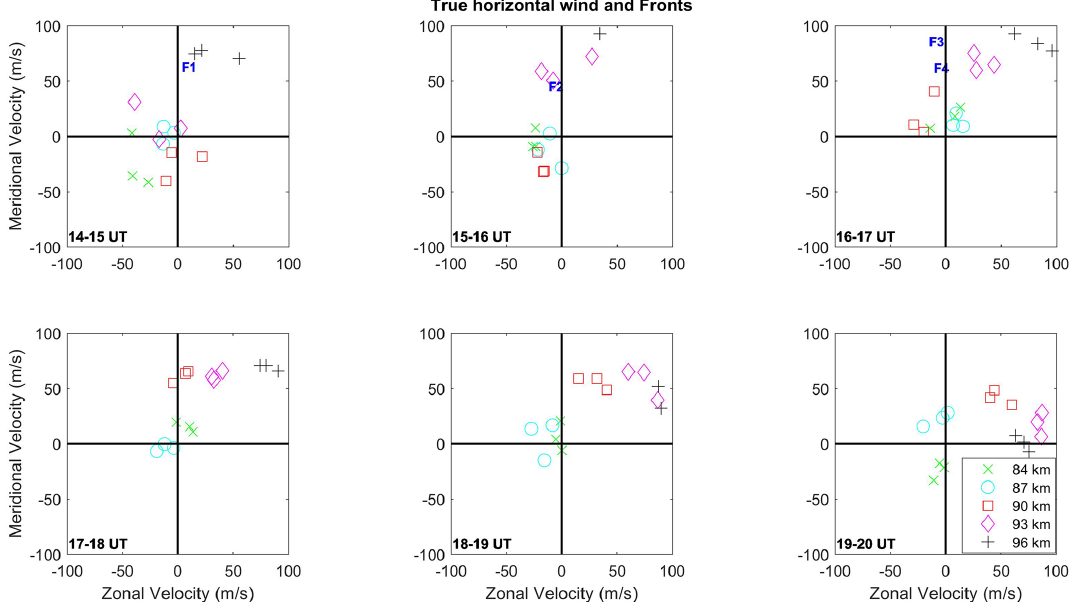
Figure 10. Horizontal wind measurements between 84 and 96km in 3km intervals and the phase velocity of the observed fronts in the respective